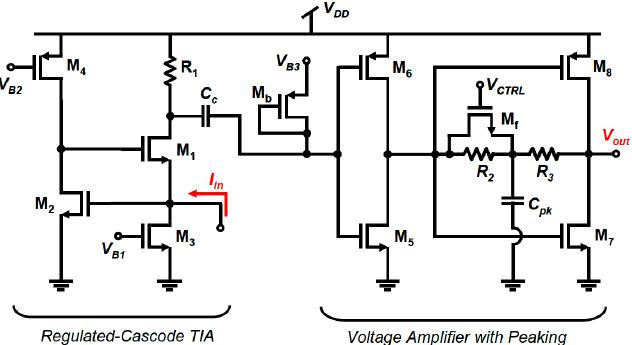
Figure 29 . Voltage gain stage used to increase the gain of the regulated cascade amplifier [253]. © 2012